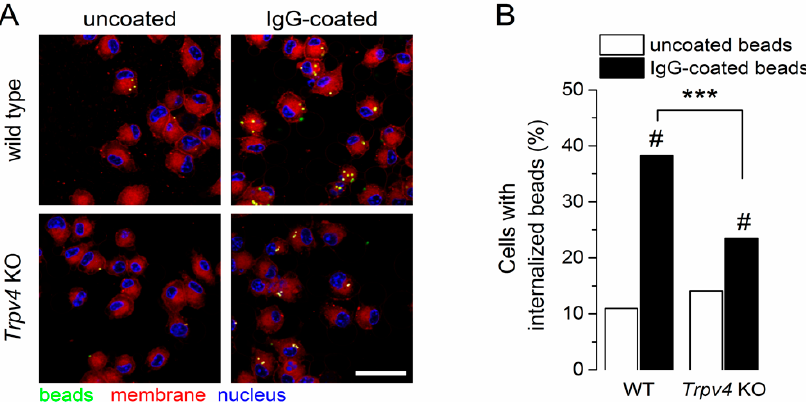
Figure 5. TRPV4-deficient BMDCs exhibited impaired FcR-dependent phagocytosis. ( A ) Representative confocal images of wild-type and Trpv4 KO BMDCs after treatment with uncoated or IgG-coated fluorescent microspheres. Scale bar, 20 µm. ( B ) Percentage of cells with internalized beads. Data were collected from 10 randomly selected fields per condition from three independent experiments. ***, p < 0.001, Fisher’s exact test for the same treatment condition across phenotypes. #, p < 0.001, Fisher’s exact test between different treatment conditions within the same phenotype.